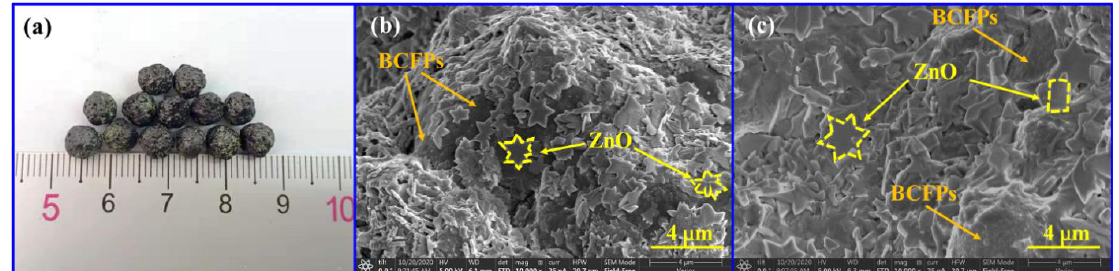
Figure 4. Optical picture ( a ) and SEM graph of particle electrode: ( b ) external surface and ( c ) internal surface (the dashed line symbols represent ZnO).